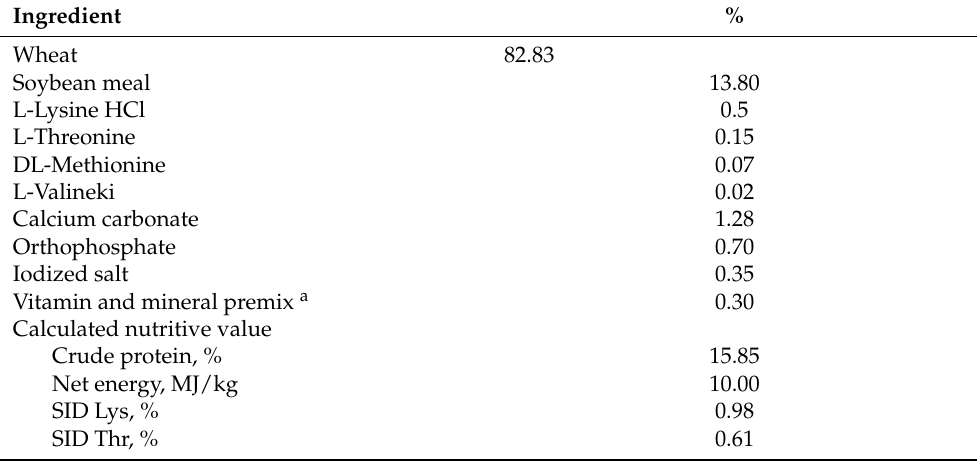
Table 1. Ingredient composition and calculated contents of the experimental diet (%, as-fed